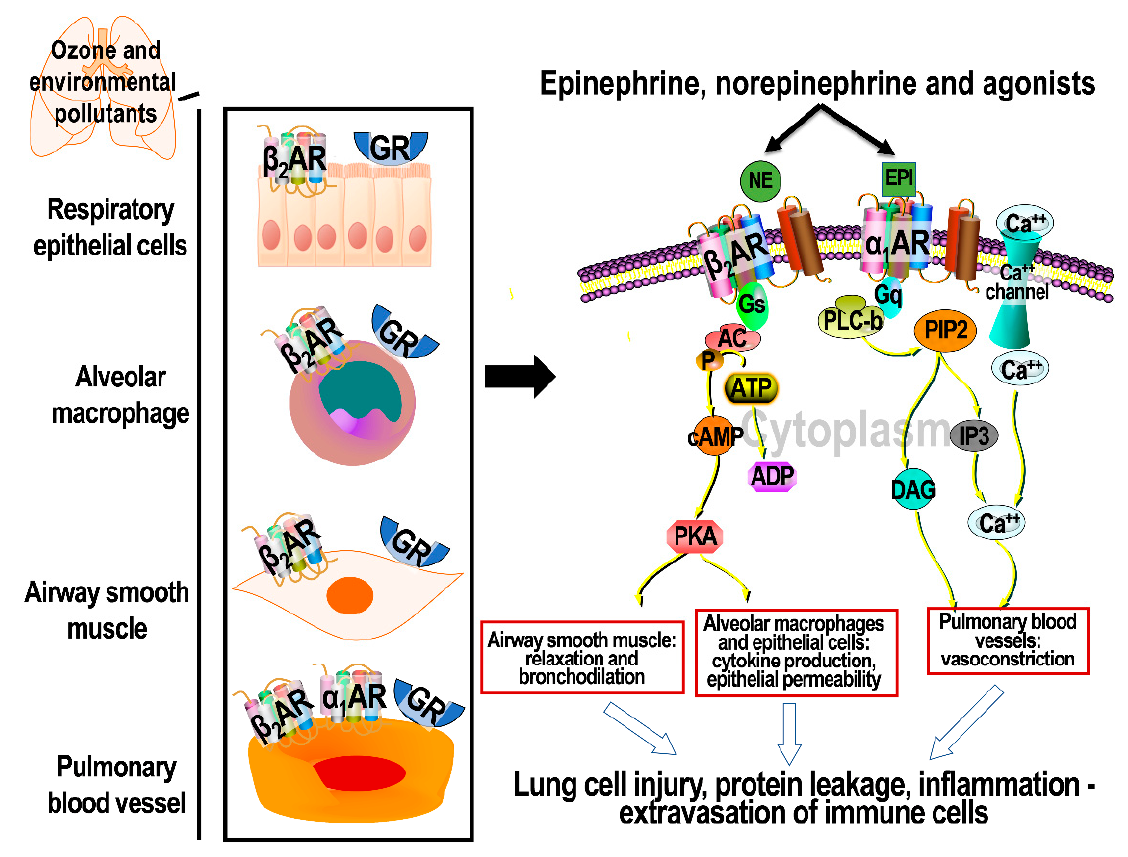
Figure 2. Schematic showing the cellular effects of activating AR subtypes in the lung. The left panel shows the distribution of α 1 AR, β 2 AR and GR in lung cells. The right panel shows cell signaling through α 1 AR and β 2 AR. β 2 AR signaling involves cAMP-mediated activation of PKA through phosphorylation, and effects on transcription factors that mediate the expression of genes regulating bronchodilation, inflammation, and epithelial transport. α 1 AR signaling, on the other hand, leads to increases in intracellular free calcium though the activation of phospholipase C and diacylglycerol, where the activation of PKC causes pulmonary vasoconstriction. β 2 AR: beta 2 adrenergic receptors; α 1 AR: alpha 1 adrenergic receptors; ATP: adenosine triphosphate; cAMP: cyclic adenosine monophosphate; PKA: protein kinase